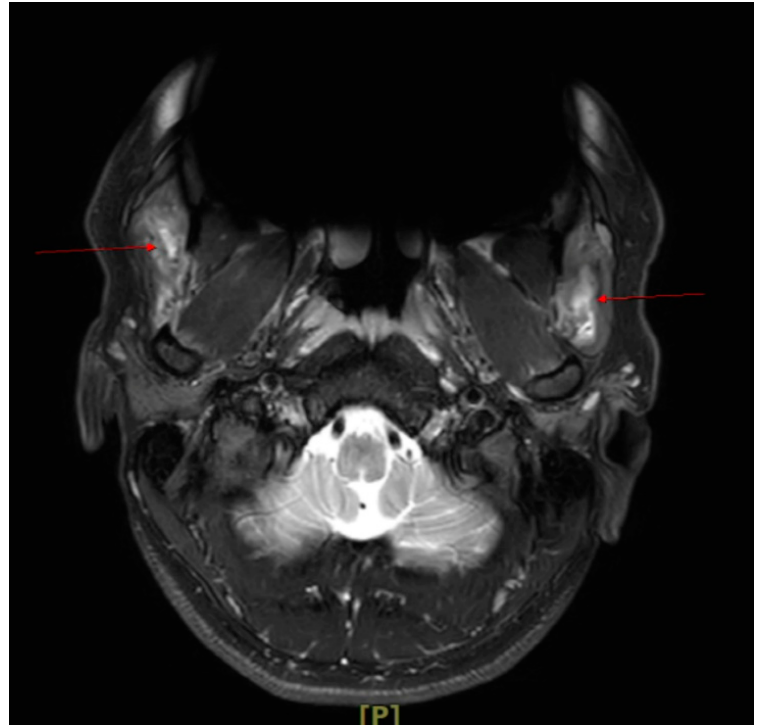
Figure 3. Temporomandibular joint magnetic resonance imaging (axial view).